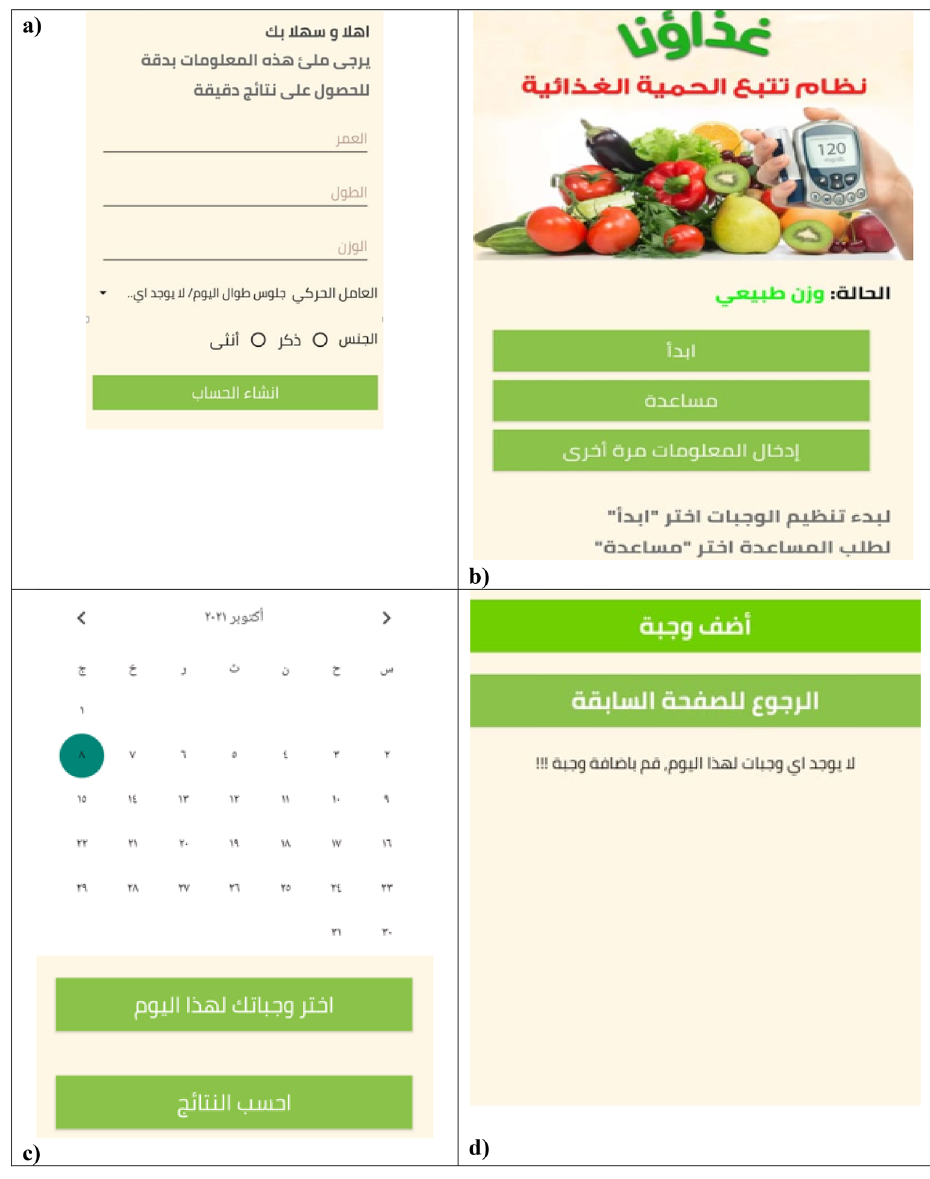
Figure 1. Screenshots taken on Samsung